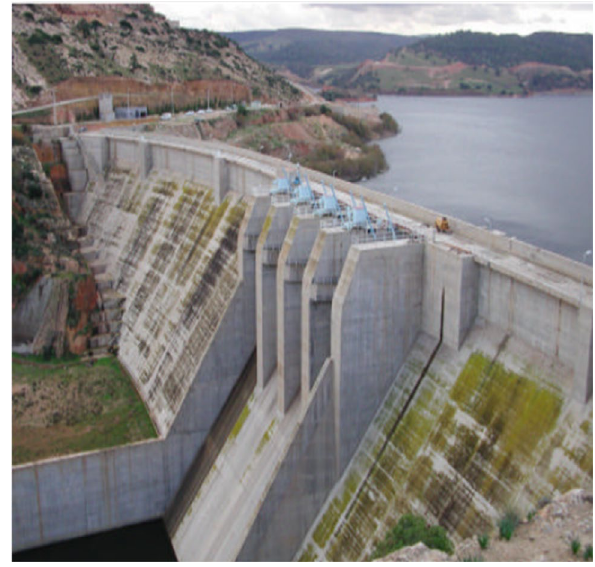
Fig. 1 Chorfa dam (region of Mascara, Algeria). ( Source : National Agency of Dams and transfers ANBT